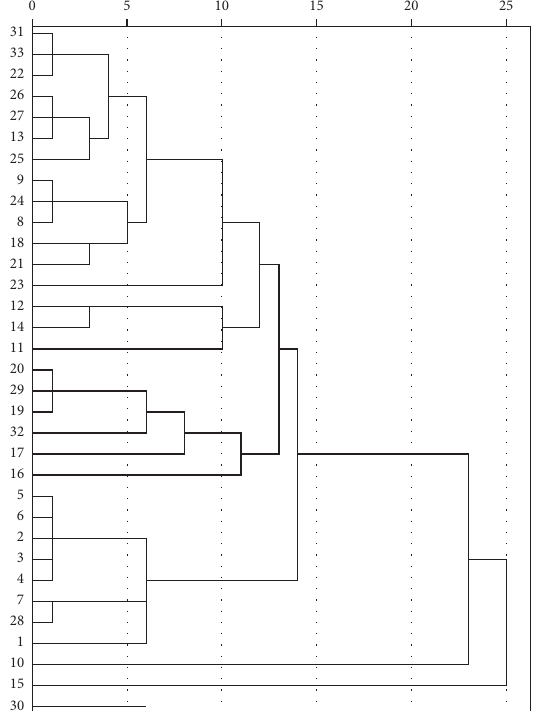
Figure 1: System cluster analysis of 33 Staphylococcus